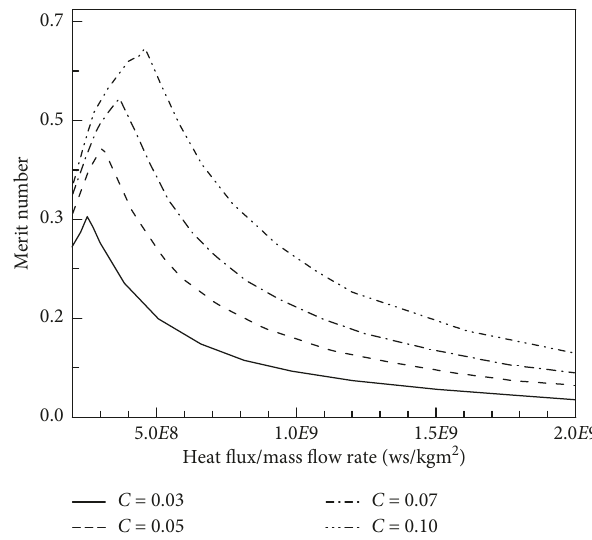
Figure 9: Effect of heat flux per unit mass flow rate on the Merit number for various concentrations of lauric acid slurry [11].